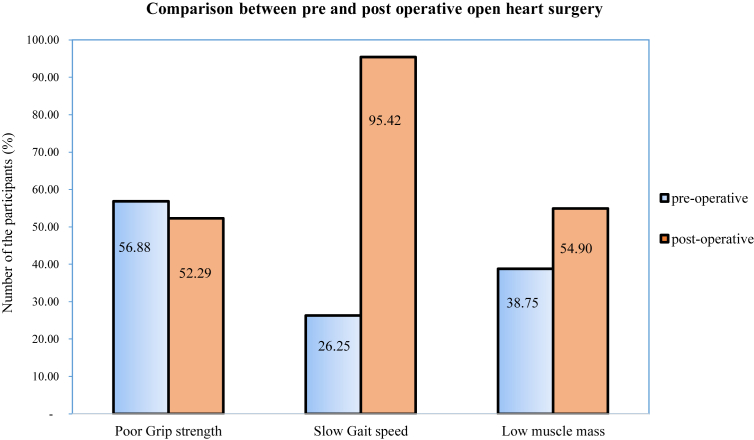
Comparison of grip strength, gait speed and muscle mass between pre and post operative open heart surgery.